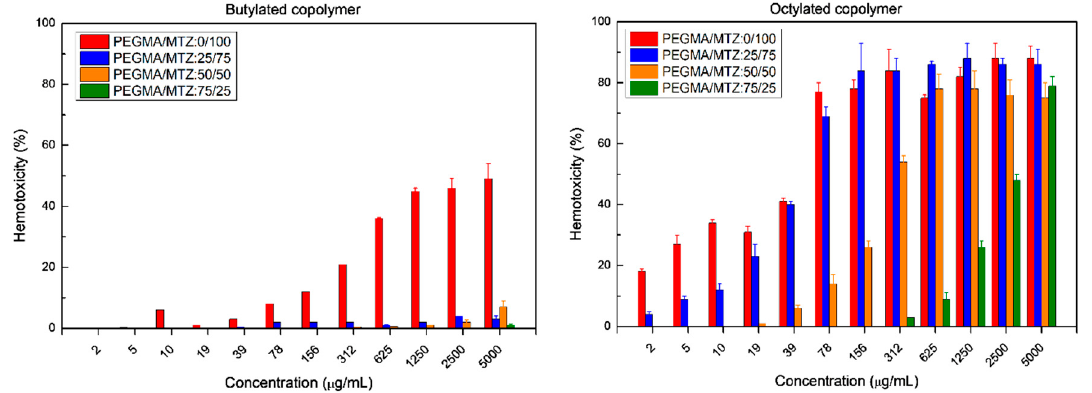
Figure 4. Hemotoxicity behavior of copolymers against red blood cells.